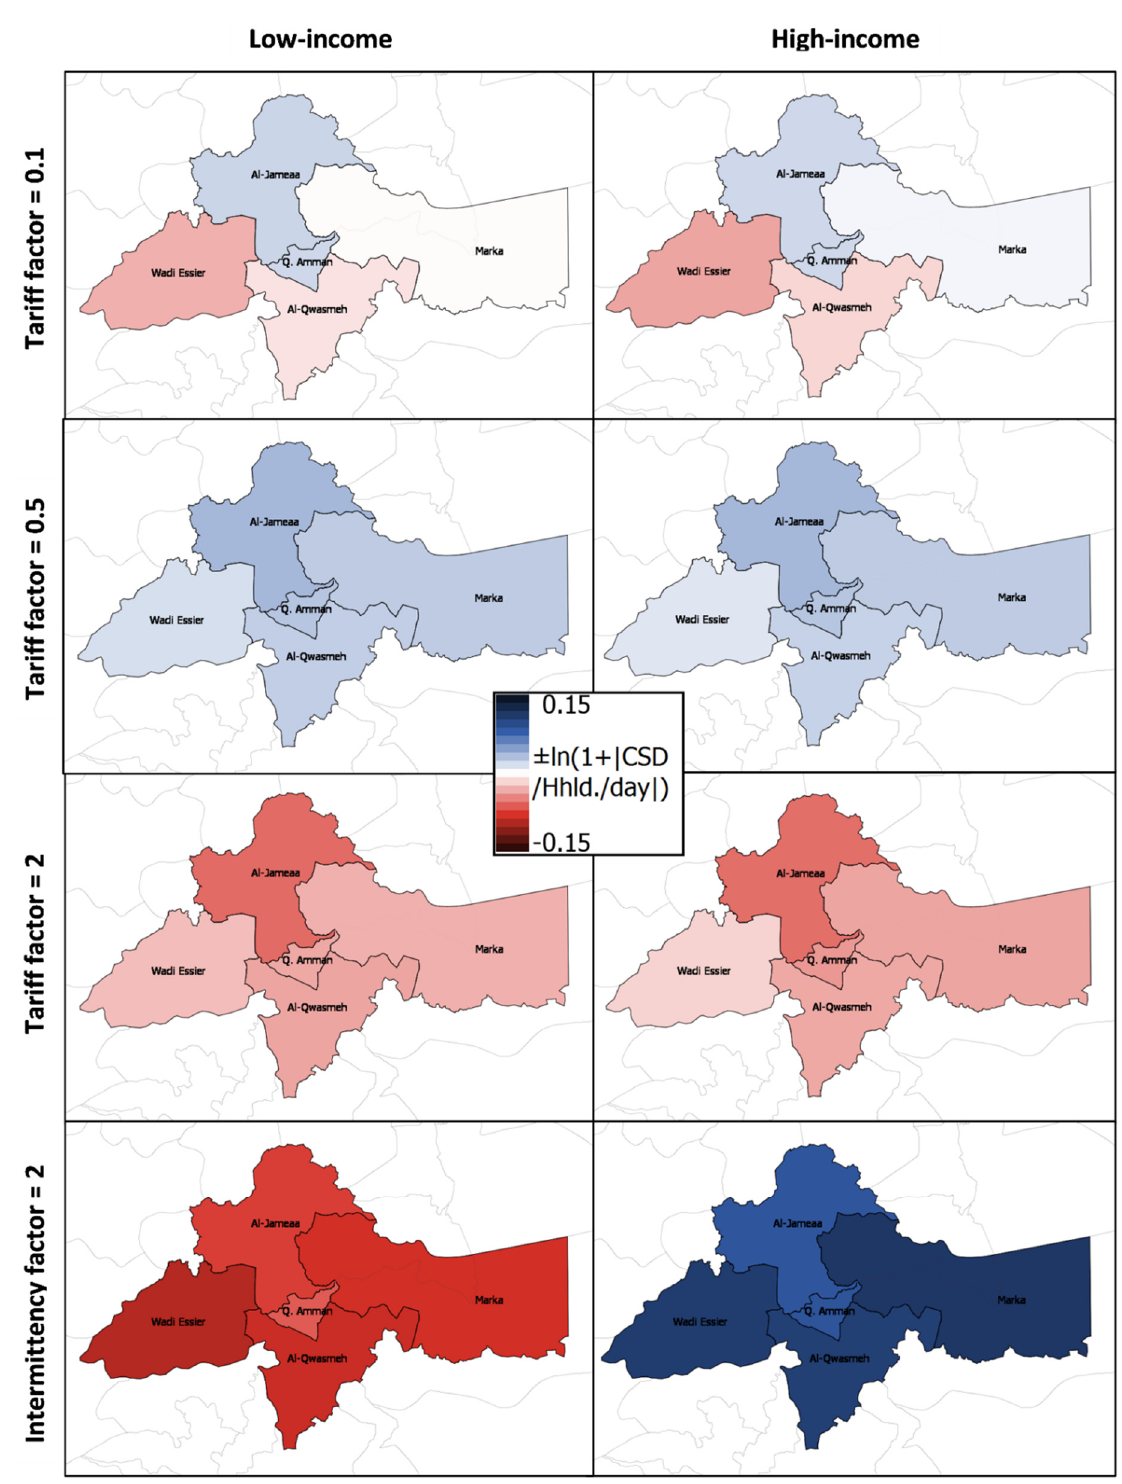
Figure 5. GIS maps showing average consumer surplus deviations from the baseline value due to changes in the piped water tariff and intermittency factors for households in different districts and income groups. Blue = gain; red = loss; darker colors indicate higher deviations from the baseline values, measured on a